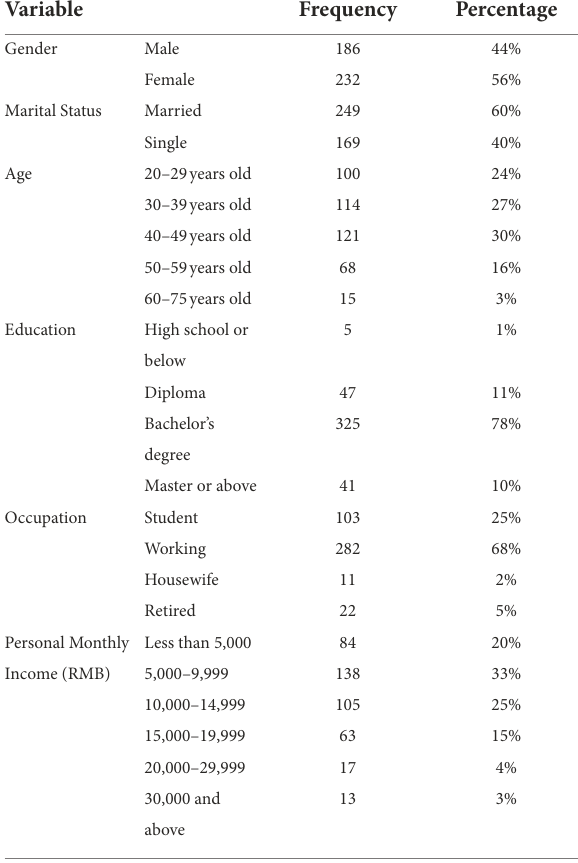
TABLE 2 Demographic profile of respondents ( N =